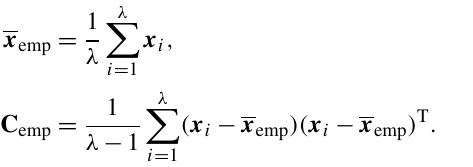
Figure 2. Iterations of the CMA-ES applied to test functions. Left: a uni-variate Griewank-type function f (grey curve). In each iteration we draw λ 10 samples from the normal distribution (blue curve). For each sample x i , the pair (x i ,f (x i )) is marked with a dot. The µ = better samples (blue dots) are involved in the normal distribution update for the next iteration. Right: two-dimensional sphere function. Here, samples are marked with dots, while function values are indicated by the grey levels in the counter plots; the i th grey level represents the (cid:17) h i 1 , i . More samples (50) than necessary are used to update the distribution, which is indicated by its standard deviation ellipse range − 2 2 (black), here. Distributions tend to elongate into directions of descent (iteration 2). For the convex example function, the algorithm converges after a few